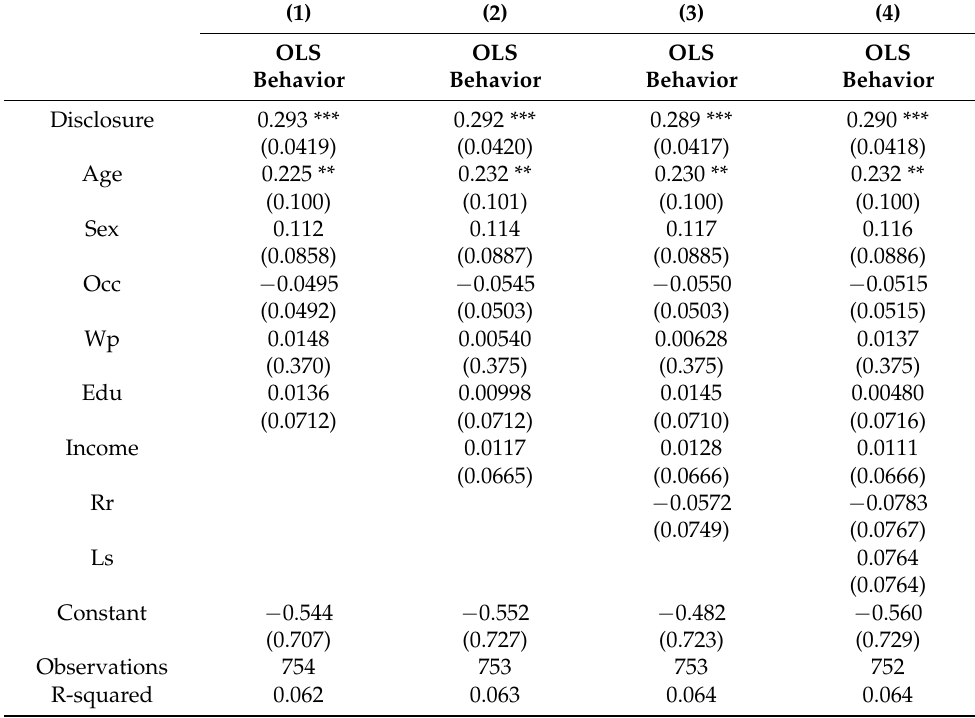
Table 3. Robustness test for stepwise addition of control